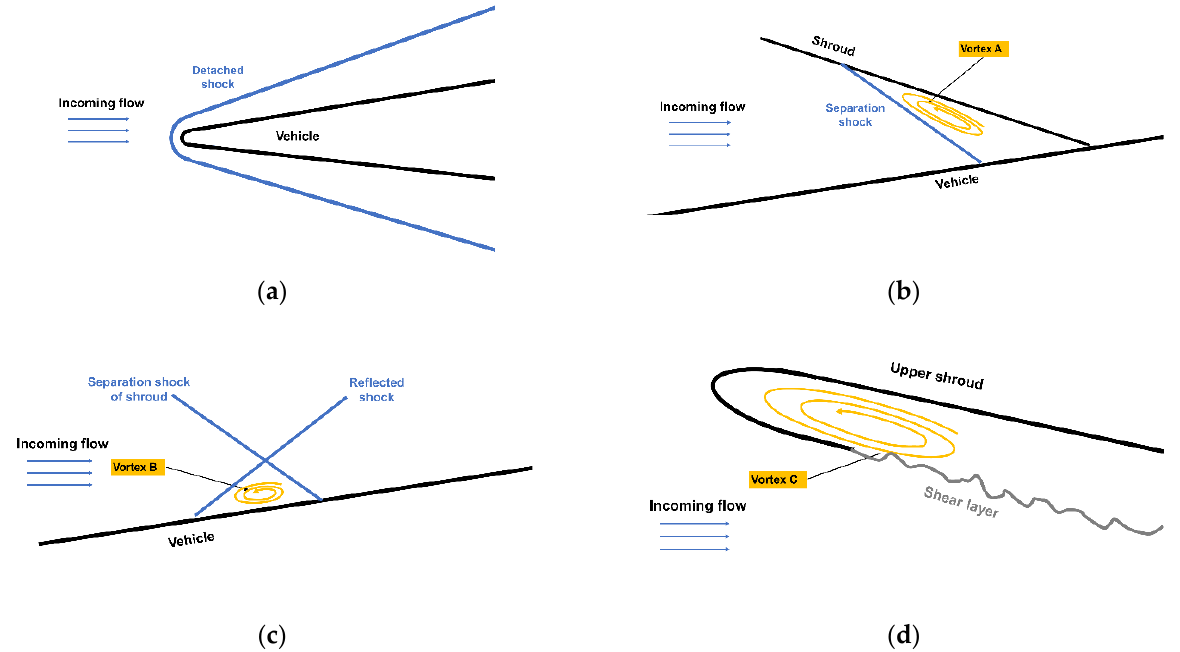
Figure 22. Schematic diagrams of the generation mechanism of shocks and vortexes in the area inside the shrouds: ( a ) detached shock; ( b ) separation shock and A-type vortex; ( c ) reflected shock and B-type vortex; and ( d ) C-type vortex.